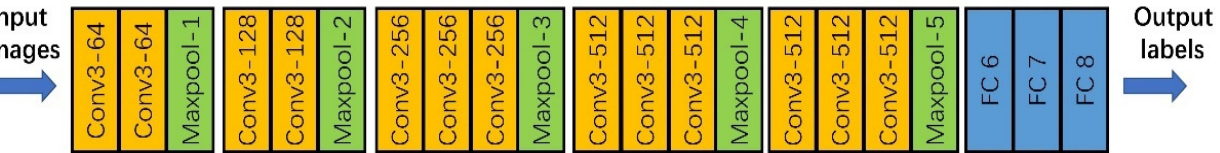
Figure 6. Structure diagram of the convolutional neural network.